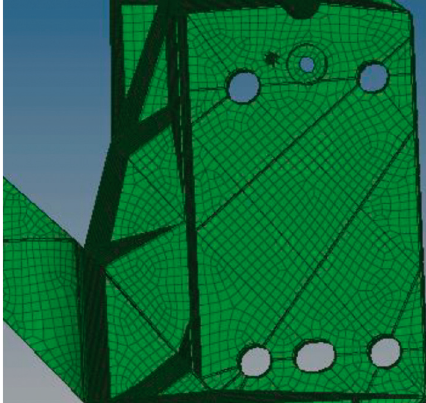
Figure 15: Local enlargement of the location of the longitudinal beam mounting point.